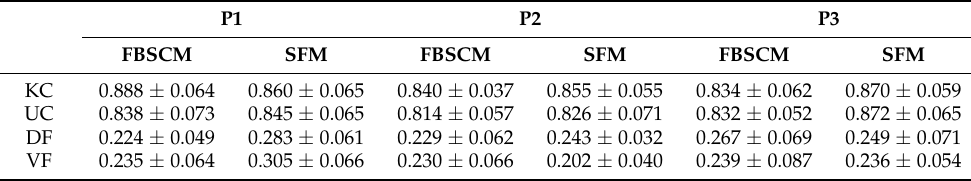
Table 1. Evaluation of the morphology of cells during their expansion. P1 P2 P3 FBSCM SFM FBSCM SFM FBSCM